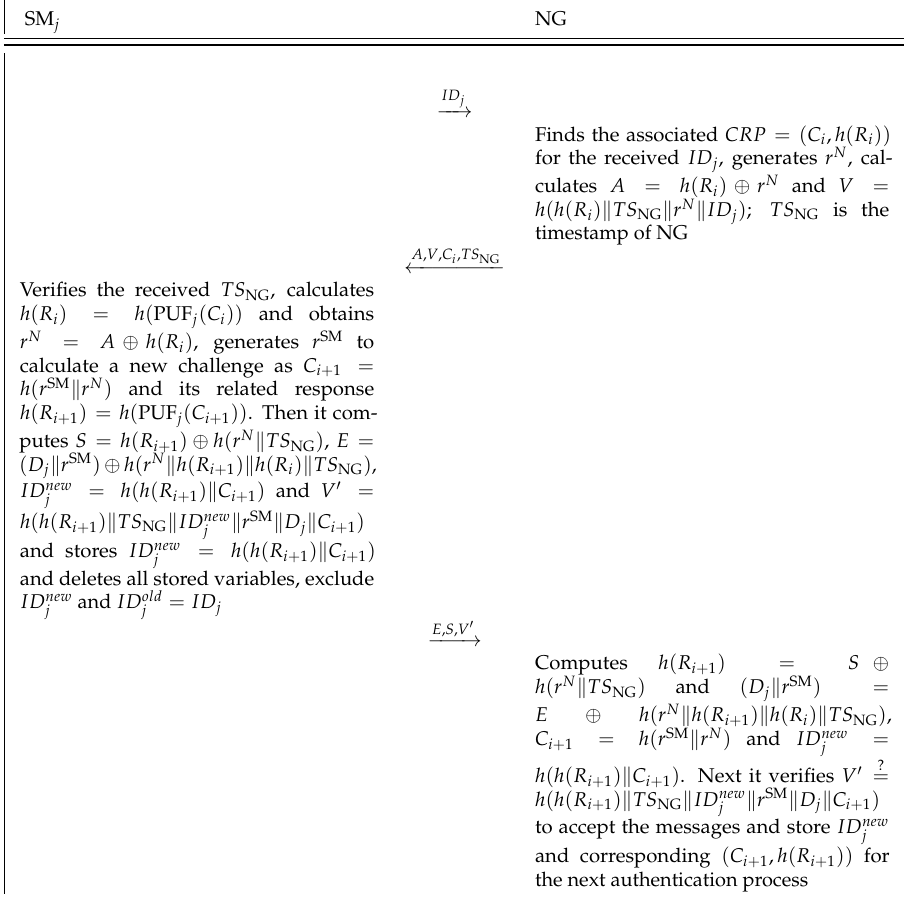
Figure 1. Mutual authentication phase of proposed